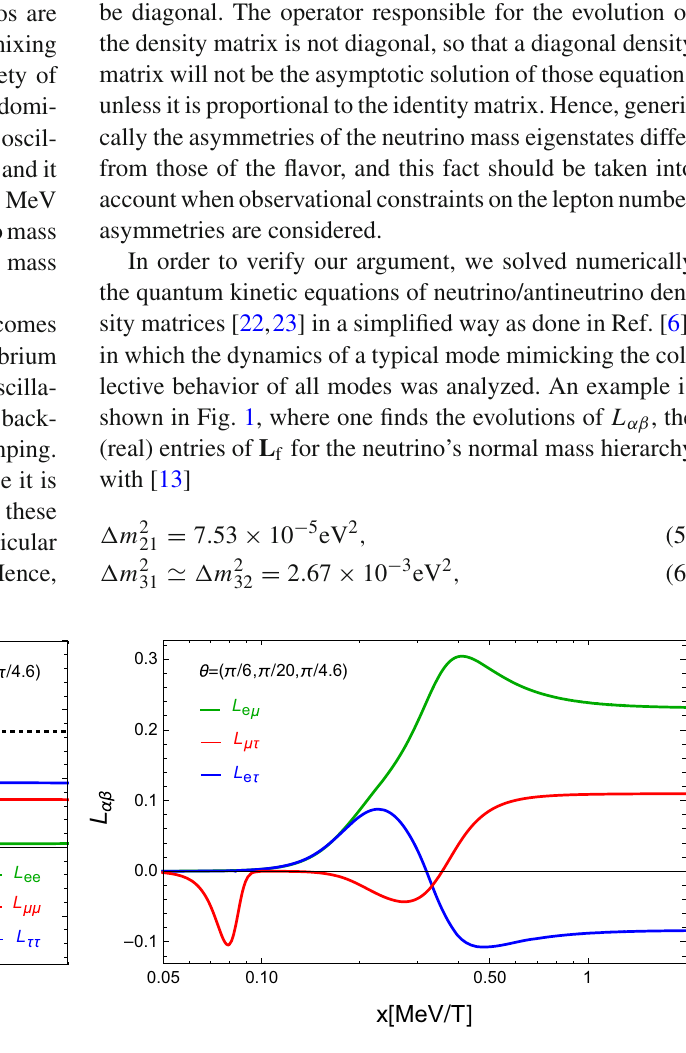
Fig. 1 Evolutions of L f for θ = (θ 12 ,θ 13 ,θ 23 ) with θ ij being the mixing angles in PMNS matrix, and (ξ e ,ξ μ ,ξ τ ) = ( − 1 . 0 , 1 . 6 , 0 . 3 ) . Left/Right diagonal/off-diagonal